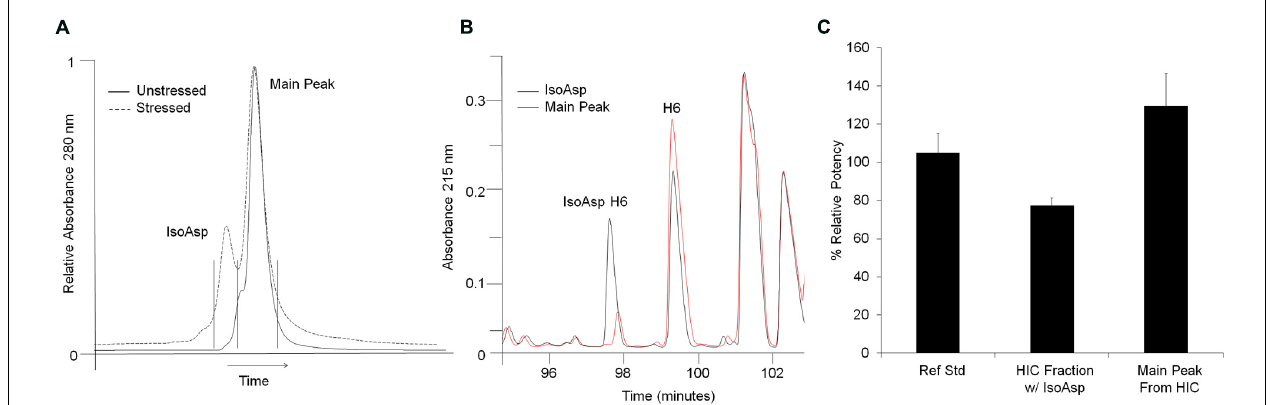
chromatographic drift. (B) Selected region of the peptide maps of HIC fractionated material.The isoAsp peak is shown in black and the main peak from stressed material in red. (C) Percent relative potency of isoAsp antibody and main peak fractions collected from HIC of stressed antibody. Potency levels are set relative to the reference standard control.